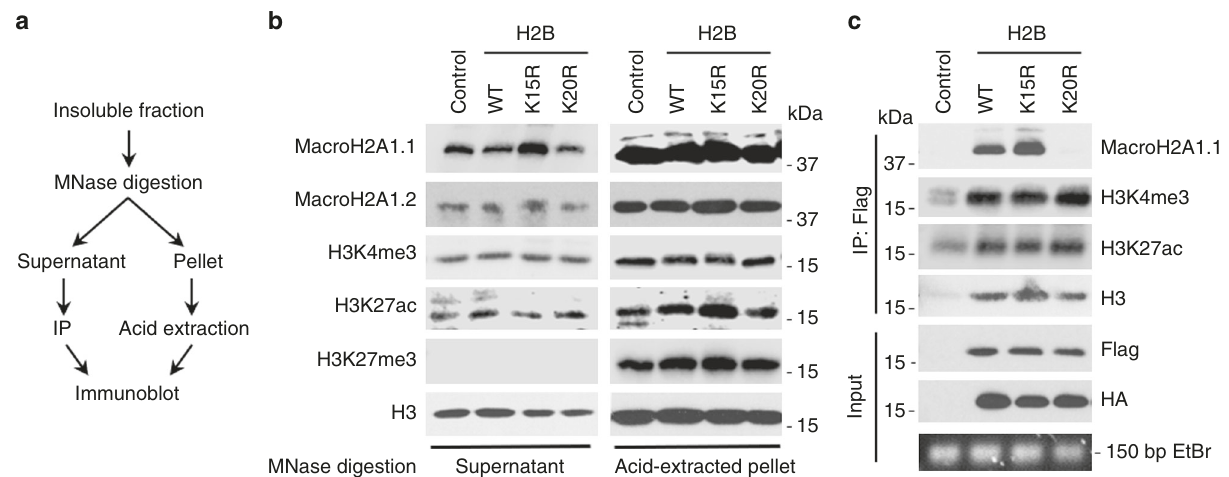
Fig. 4 MacroH2A1.1 associates with H2B K20 acetylation in mononucleosomes. a Schematic for micrococcal nuclease (MNase) digestion and fractionation of euchromatic mononucleosomes for immunoprecipitation (IP) using Flag antibody. b Immunoblots from fractionated MNase digested cells expressing H2B mutants described in (Fig. 3b) from the supernatant and acid-extracted pellet for indicated histones and histone PTMs. c Immunoblots for indicated histones and histone PTMs of mononucleosome Flag IP and input material from cells described in (Fig. 3b). Bottom box is ethidium bromide stained DNA band